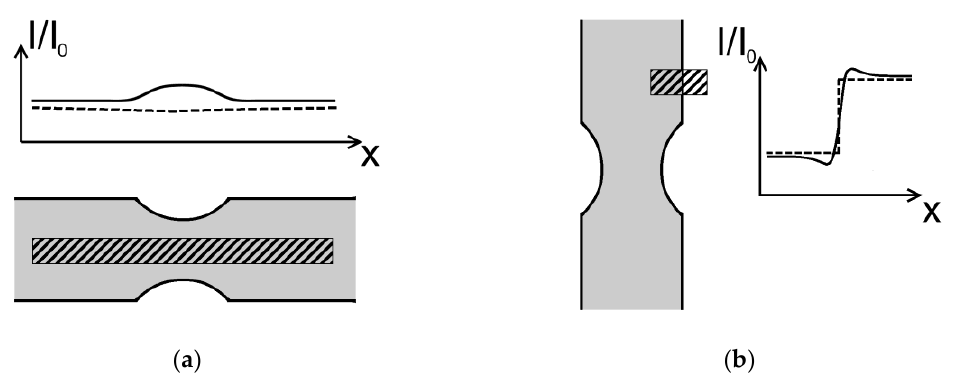
Figure 1. Measured (solid line) and expected (dashed line) intensity curves of regions of interest (ROI) (shaded rectangles). ( a ) ROI in a hydrogenous sample, parallel to the samples axis; ( b ) ROI in a sample without hydrogen, which covers the sample, the samples edge and air.